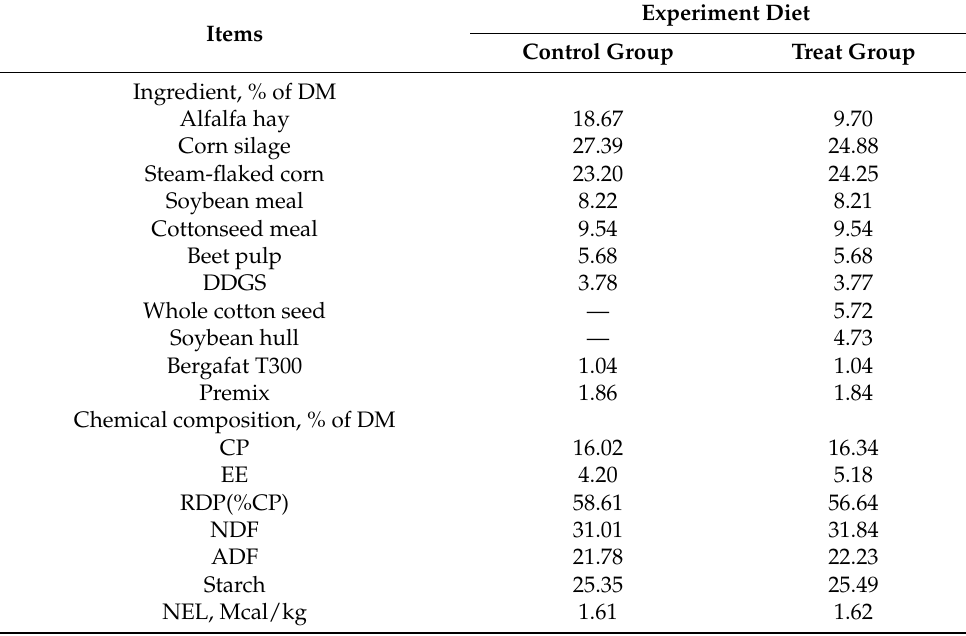
Table 1. The TMR diets of control group and treat